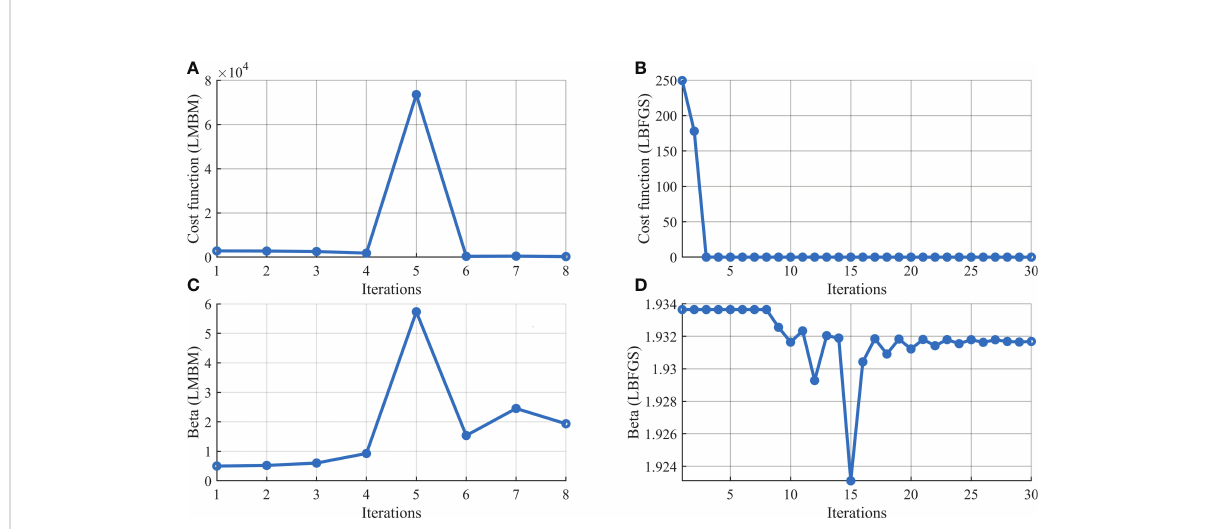
FIGURE 10 The evolution of (A, B) the cost function and (C, D) b value with LMBM and LBFGS algorithms for B_IN b experiment,